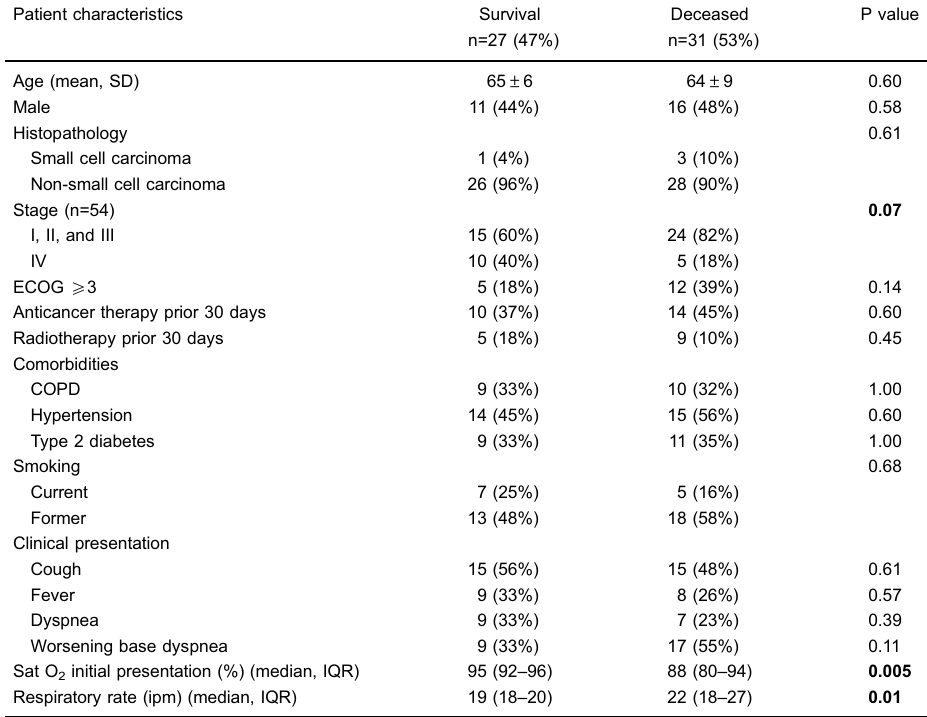
Table 4. Patient characteristics according to